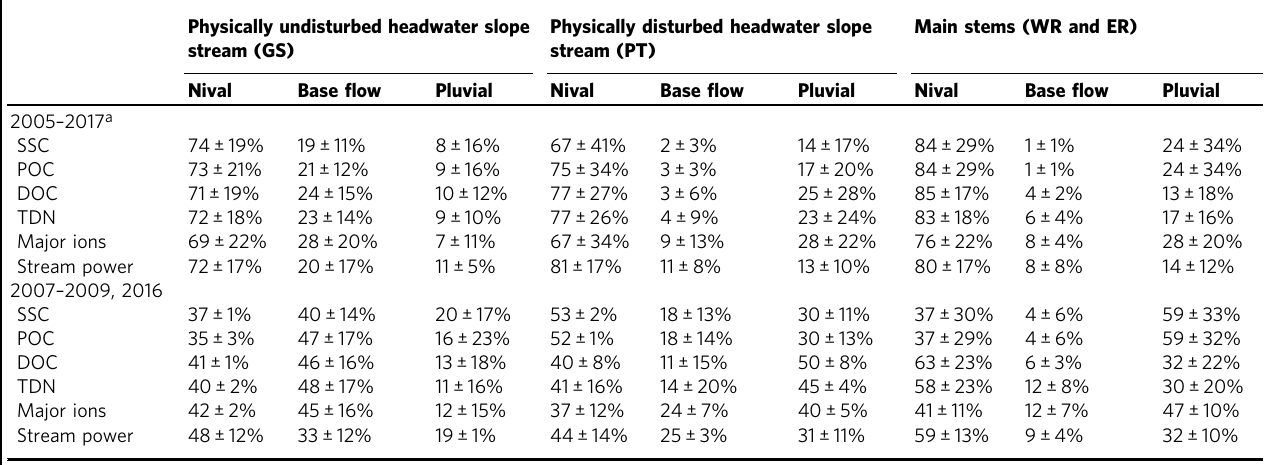
Table 1 Mean ± SD proportions of annual fl ux from each hydrological period at the CBAWO. Physically undisturbed headwater slope stream (GS)